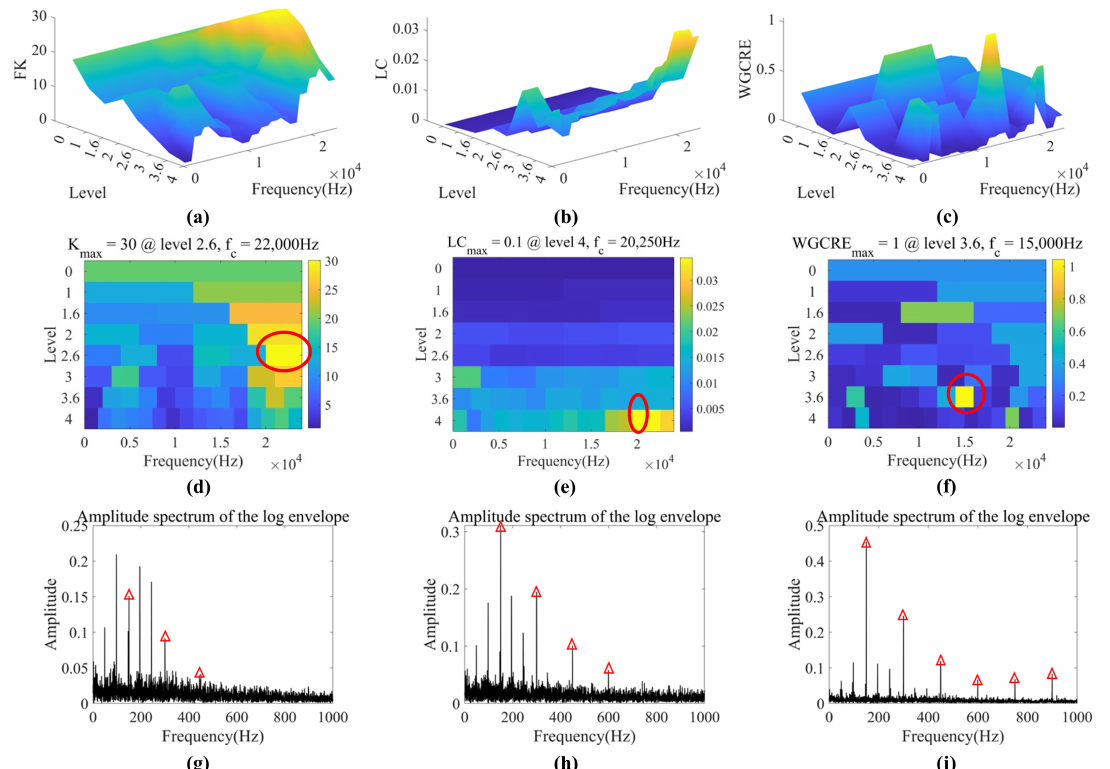
Figure 13. Optimal bands extraction of Case 2 (outer race fault). ( a – f ) are 3D and 2D FK, LC , and WGCRE –gram, respectively (optimal bands are circled in red). ( g – j ) are LES of FK, LC , and WGCRE , respectively (BPFOs with harmonics are marked with red triangles).